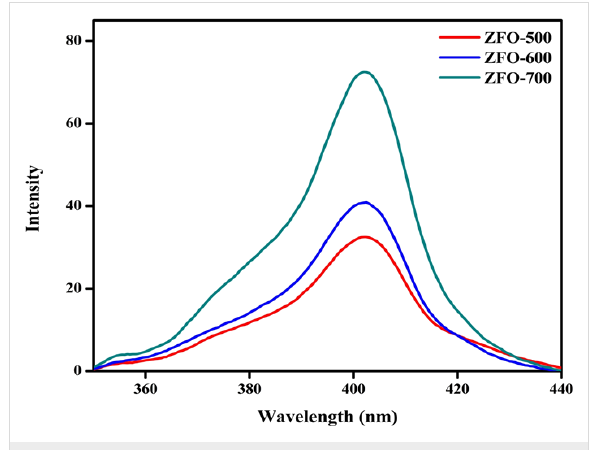
Figure 5: Photoluminescence spectra of ZFO samples excited at 330